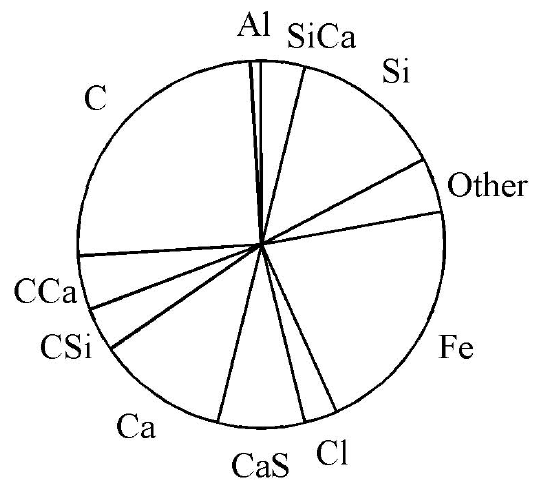
Fig. 5. The proportion of EDX spectra dominated by one or two